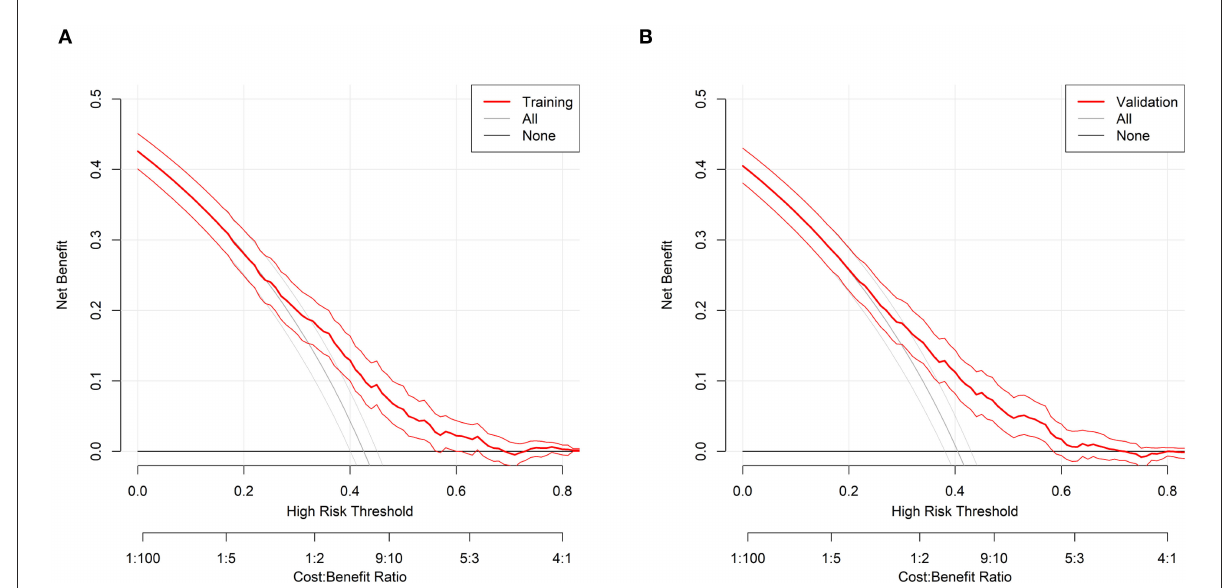
FIGURE8 Decision analysis curve for the nomogram in the two groups. (A) The training group; (B) the validation group. Decision analysis curve is plotted by different risk threshold against net benefit. There are two lines for reference: A gray line indicates treated-for-all scheme, and a black line indicates treated-for-none scheme.